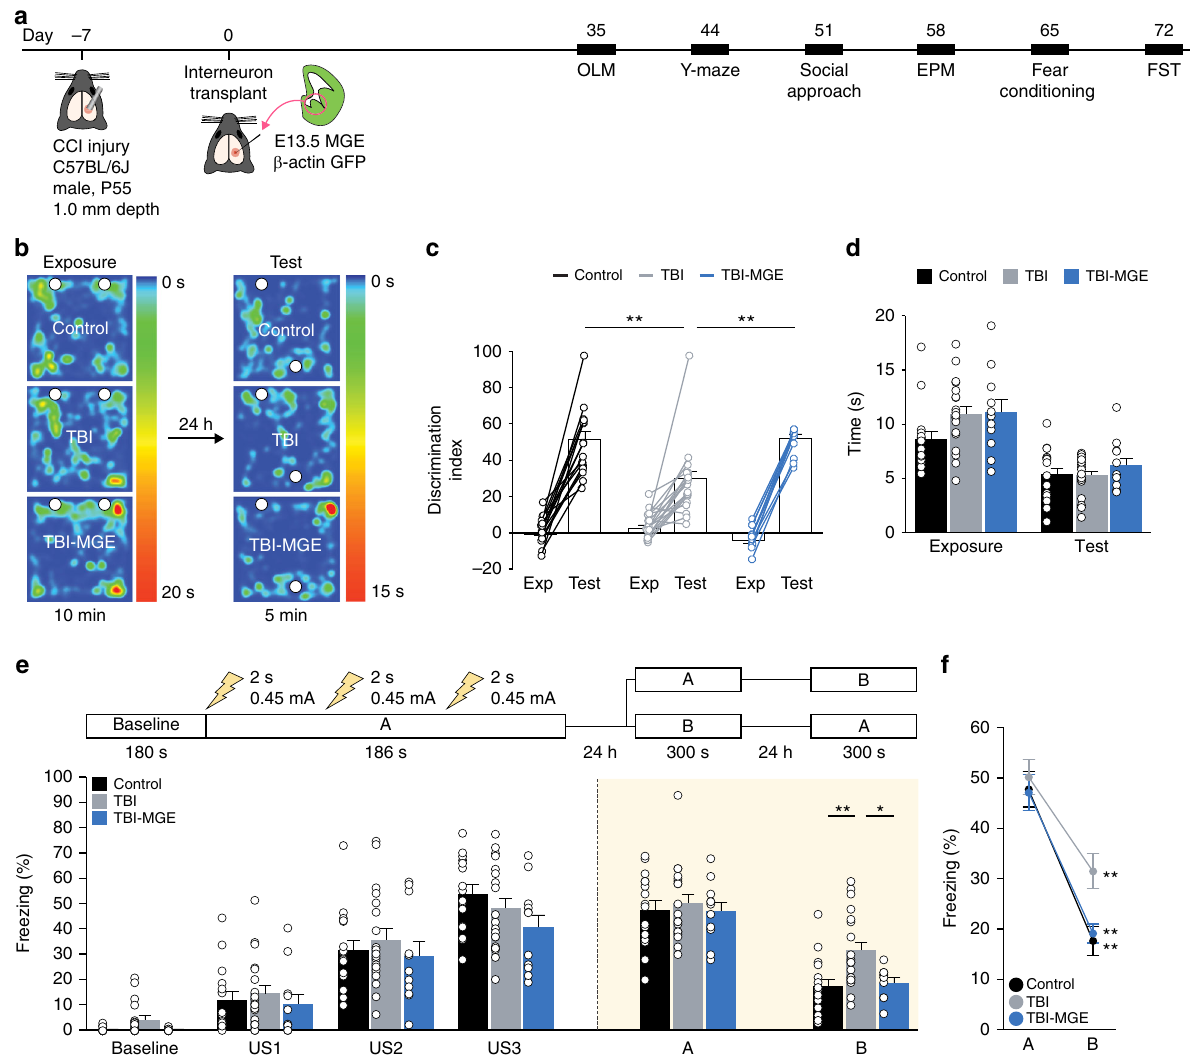
Fig. 5 MGE transplantation improves memory after TBI. a Schematic showing the timeline for behavior experiments. OLM object location memory, EPM elevated plus maze, FST forced swim test. b Heatmap showing the location of control, TBI and TBI-MGE mice during exposure and testing phases of the OLM assay. c Discrimination index for each individual mouse and group means during exposure and testing phases of OLM. ** P = 0.002, control vs TBI; ** P = 0.004, TBI vs TBI-MGE; one-way ANOVA with Bonferroni post hoc test. n = 16 control mice, 19 TBI mice and 11 TBI-MGE mice. d Total time spent exploring the objects during exposure phase and test phase of OLM. e Top, schematic of the contextual fear conditioning paradigm. Bottom, quanti fi cation of freezing behavior in contexts A and B. ** P = 0.004, control vs TBI; * P = 0.03, TBI vs TBI-MGE; one-way ANOVA with Bonferroni post hoc test. n = 16 control mice, 19 TBI mice and 11 TBI-MGE mice. US, unconditioned stimulus (i.e., foot shock). f Quanti fi cation of freezing in contexts A and B. ** P = 0.000008, control; ** P = 0.000004, TBI; ** P = 0.00002, TBI-MGE; two-tailed paired t- tests. Error bars, s.e.m. See Supplementary Data 1 for statistical analyses. Source data are provided as a Source Data fi